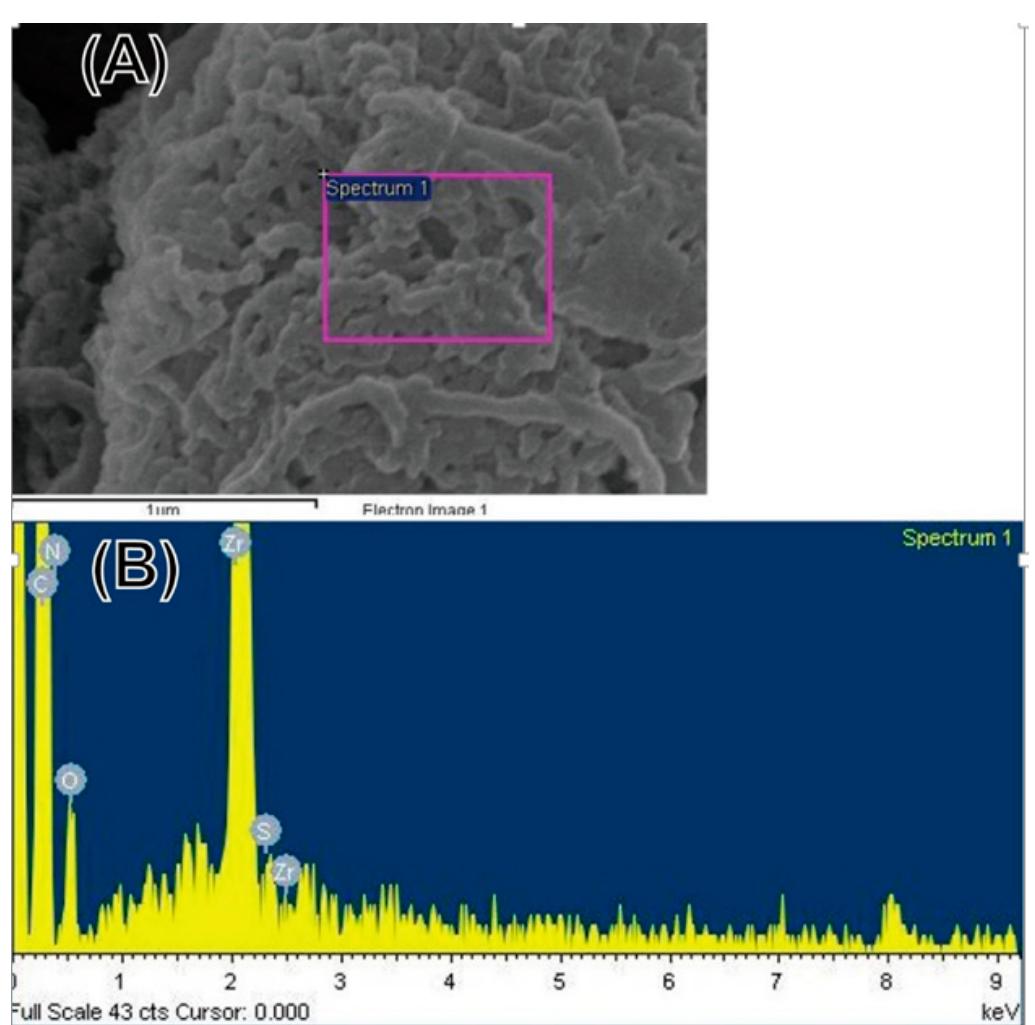
Figure 8. ( a ) SEM image of CD133-conjugated LEVA/PVP/PMMA MPs. ( b ) EDX spectrum acquired Figure 8. ( A ) SEM image of CD133-conjugated LEVA / PVP / PMMA MPs. ( B ) EDX spectrum acquired from the selected area on the CD133-conjugated LEVA/PVP/PMMA MPs. from the selected area on the CD133-conjugated LEVA / PVP / PMMA